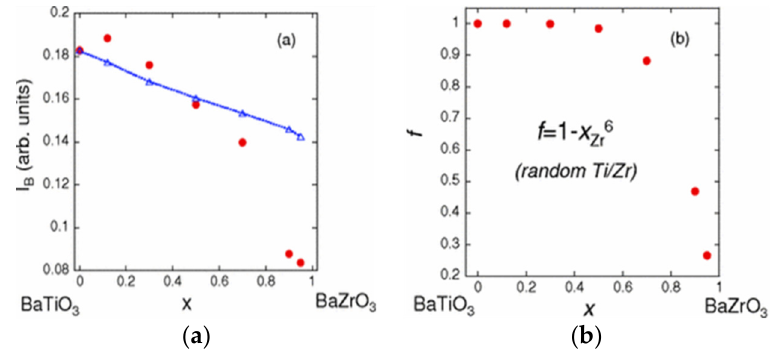
Figure 16. Compositional dependence of the area of pre ‐ edge peak B in Ti K ‐ edge XANES spectra (red circles). ( a ) The blue dashed line/triangles indicate the peak B area reduction according to the a 5.5 term in Equation (2) if a values are equal to the XRD lattice parameter; ( b ) Calculated compositional dependence of the fraction f of Ti cations having one or more Ti as a next ‐ nearest neighbor for a random distribution of Ti and Zr cations occupying the sites B in perovskites. Reprinted figure with permission from [107]. Copyright by the American Physical Society, 2011.